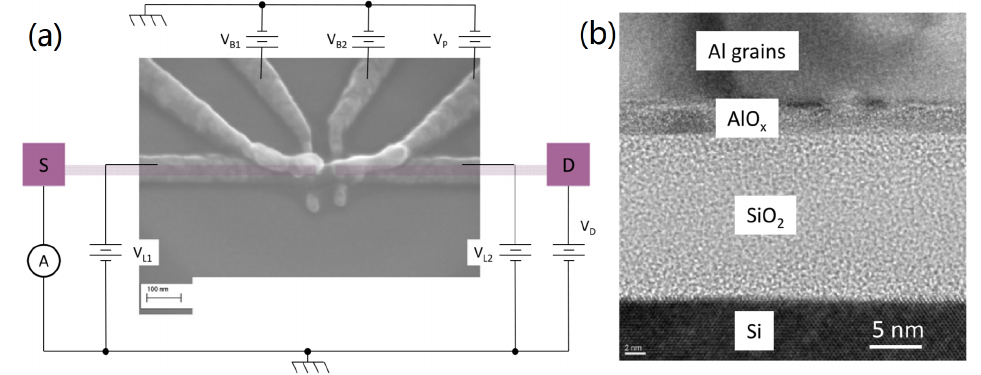
Figure 10. SED made in silicon with Al gates. ( a ) micrograph of the device and the measurement circuit used for the charge offset drift measurement; ( b ) TEM micrograph of the device along the source to drain direction directly under the plunger gate, P. The micrograph shows that a non-deliberate AlO x layer forms at the interface between the SiO 2 gate oxide and the Al gates. Reproduced with permission from reference [48], Copyright 2014, Institute of Physics.